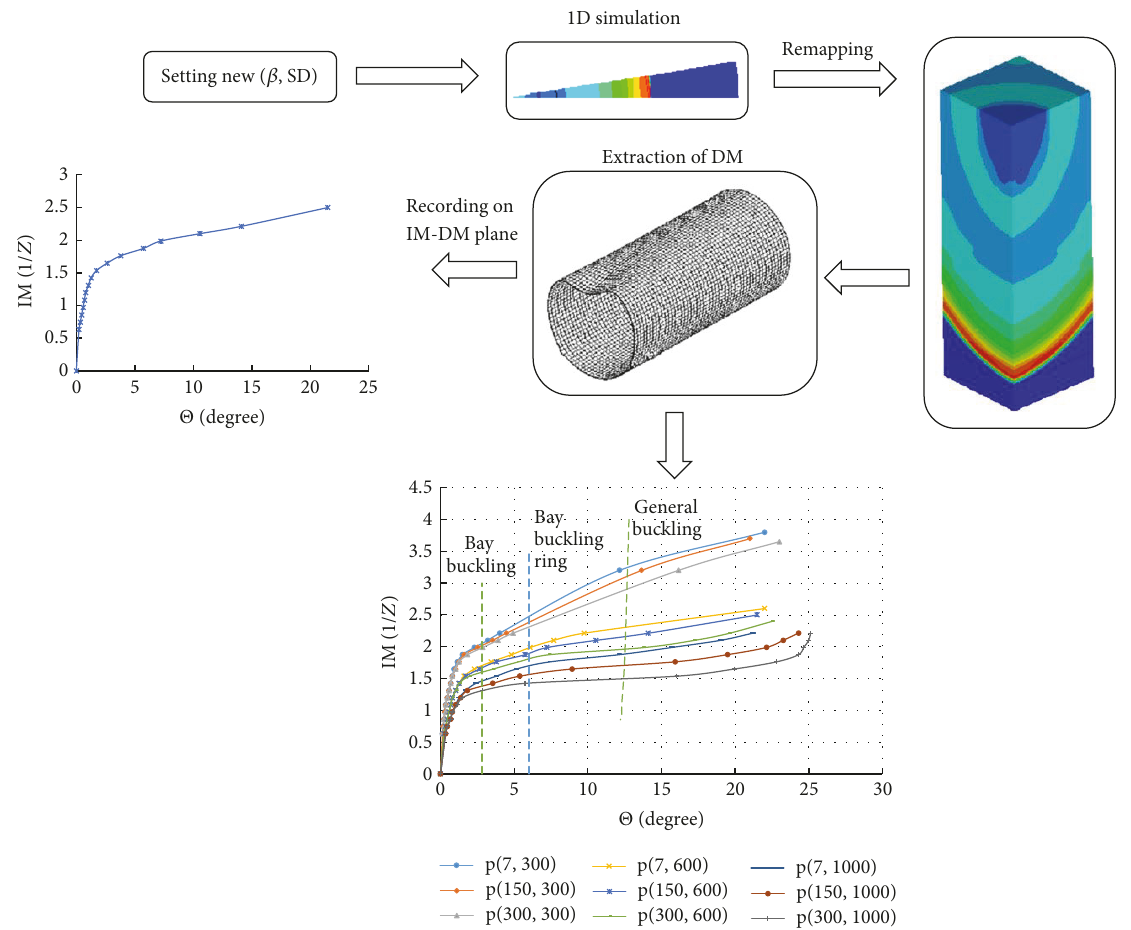
Figure 7: Schematic representation of the incremental explosive analysis (IEA) procedure.